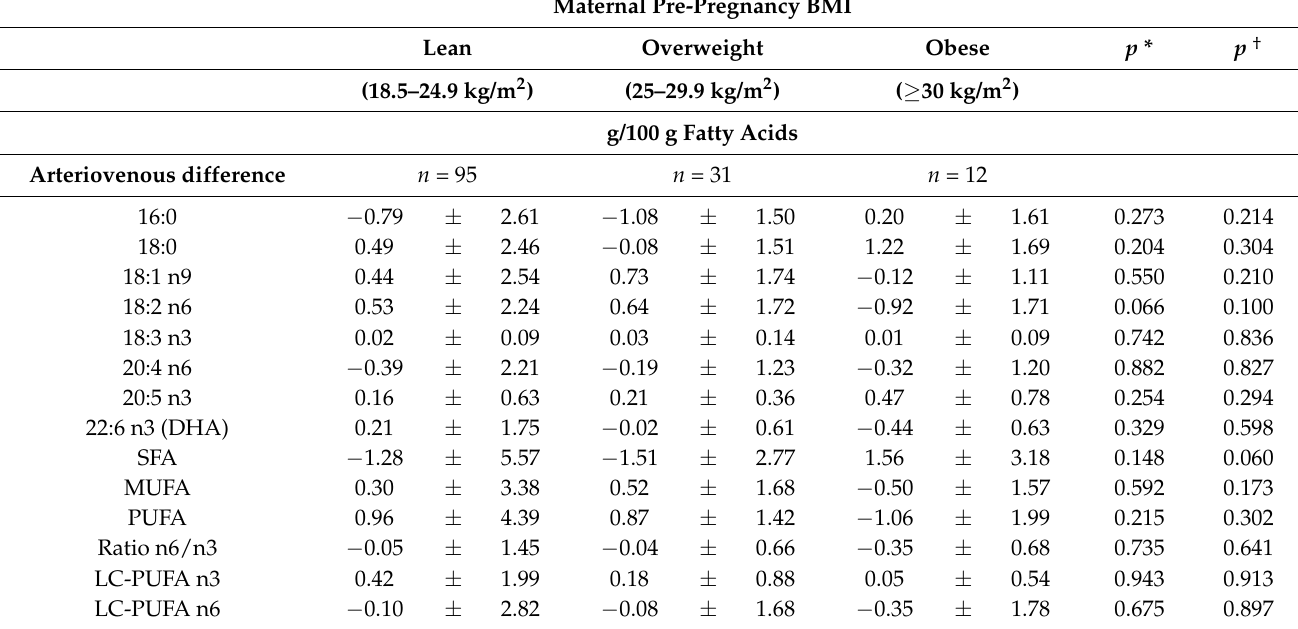
Table 2. Cont. Maternal Pre-Pregnancy